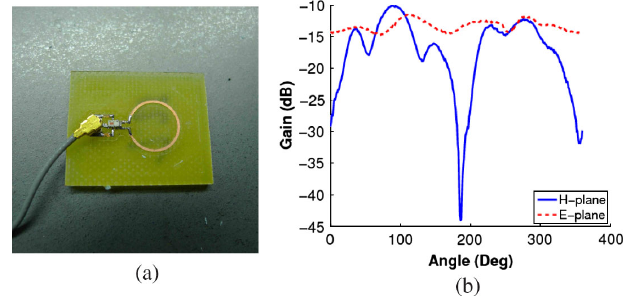
FIG. 5. (a) The fabricated loop antenna. (b) The measured radiation pattern of the loop antenna. Two cuts of the 3D pattern are shown, indicating the dipolar nature of the antenna.